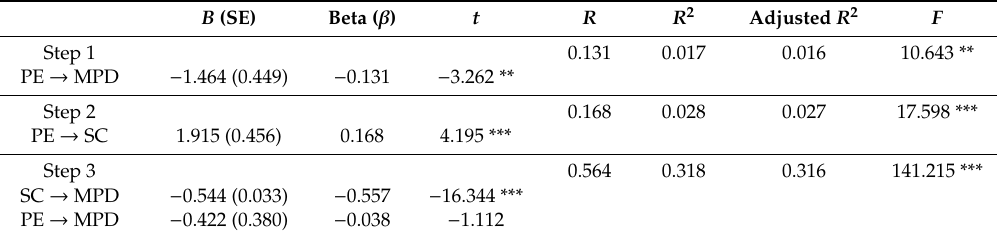
Table 4. Regression analysis to test the mediating e ff ect of SC between PE and